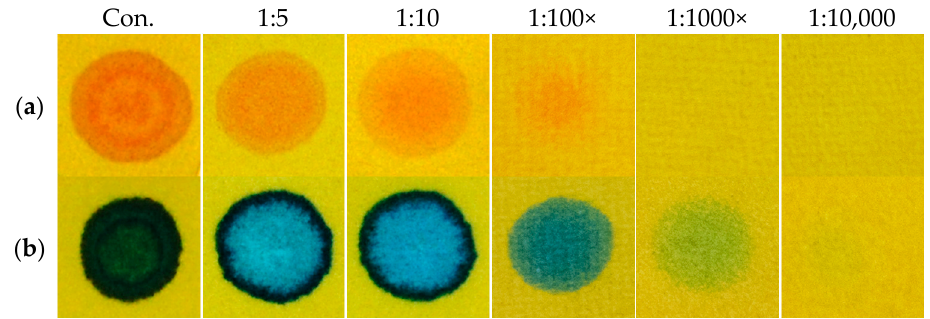
Figure 12. Influence of CWA dilution to the RM1a/PY-OPD/BCG/colophon detection paper colour intensity, ( a ) GD, ( b ) VX.